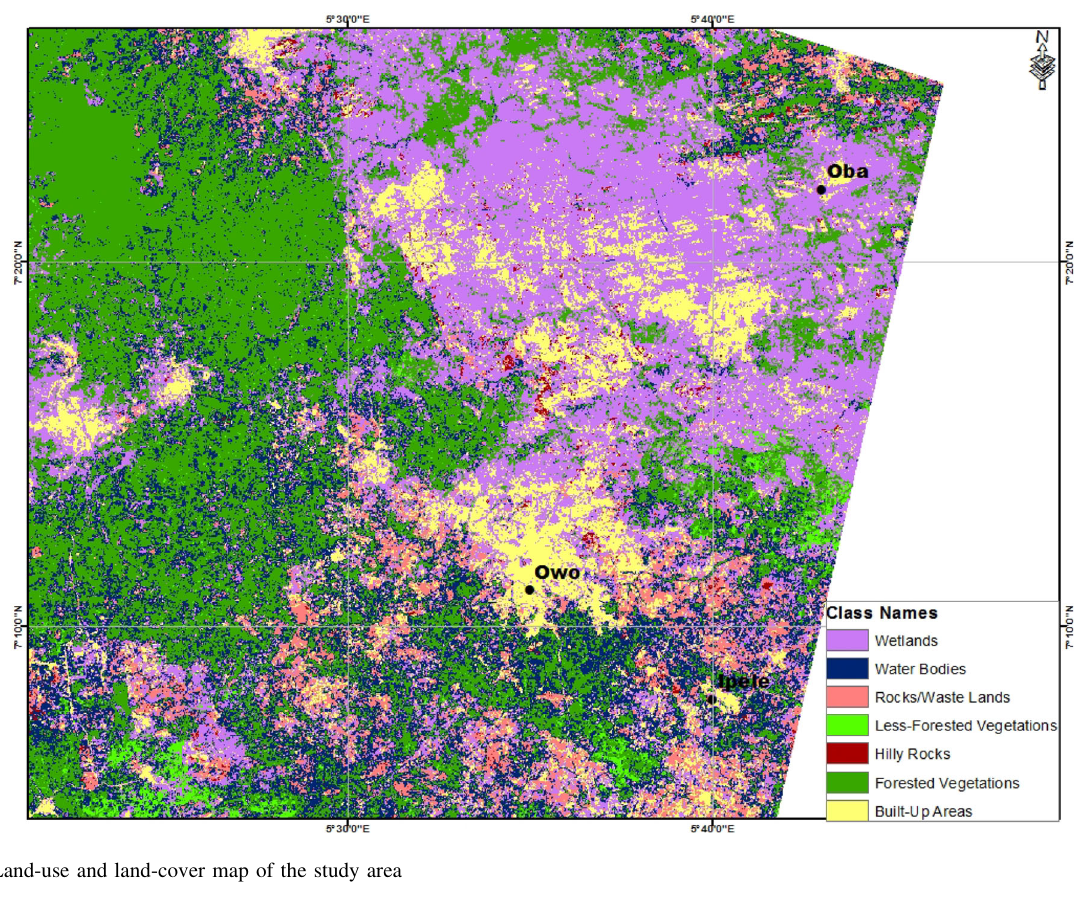
Fig. 8 Land-use and land-cover map of the study area